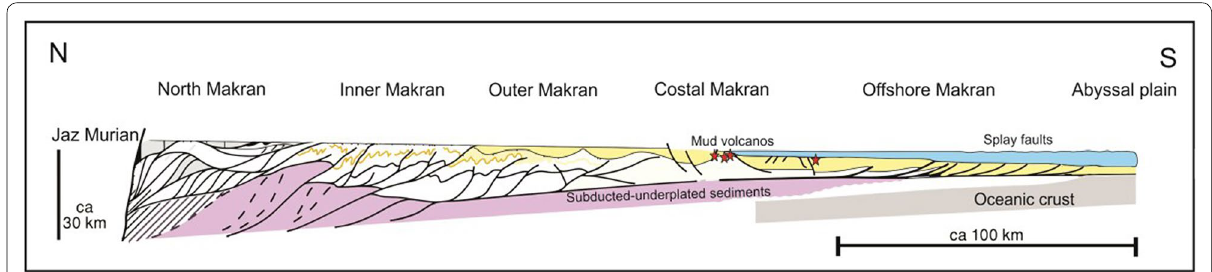
Fig. 6 A North–South cross section based on the data available in the region, both onshore fold and thrust and offshore Makran Accretionary Wedge (modified after Burg et al.